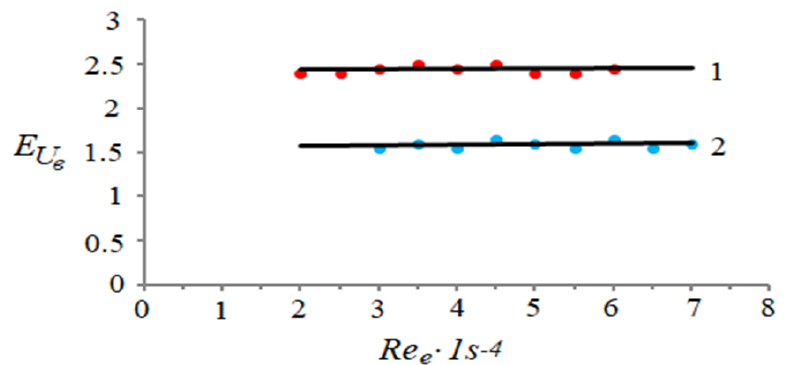
Figure 2. Dependence of the Euler’s number E U of an operating path of the vortex heat generator on the ℜ в path load: (1) heat generator with the installed vortex accelerator of the liquid flow and (2) heat generator without the vortex accelerator of liquid flow.